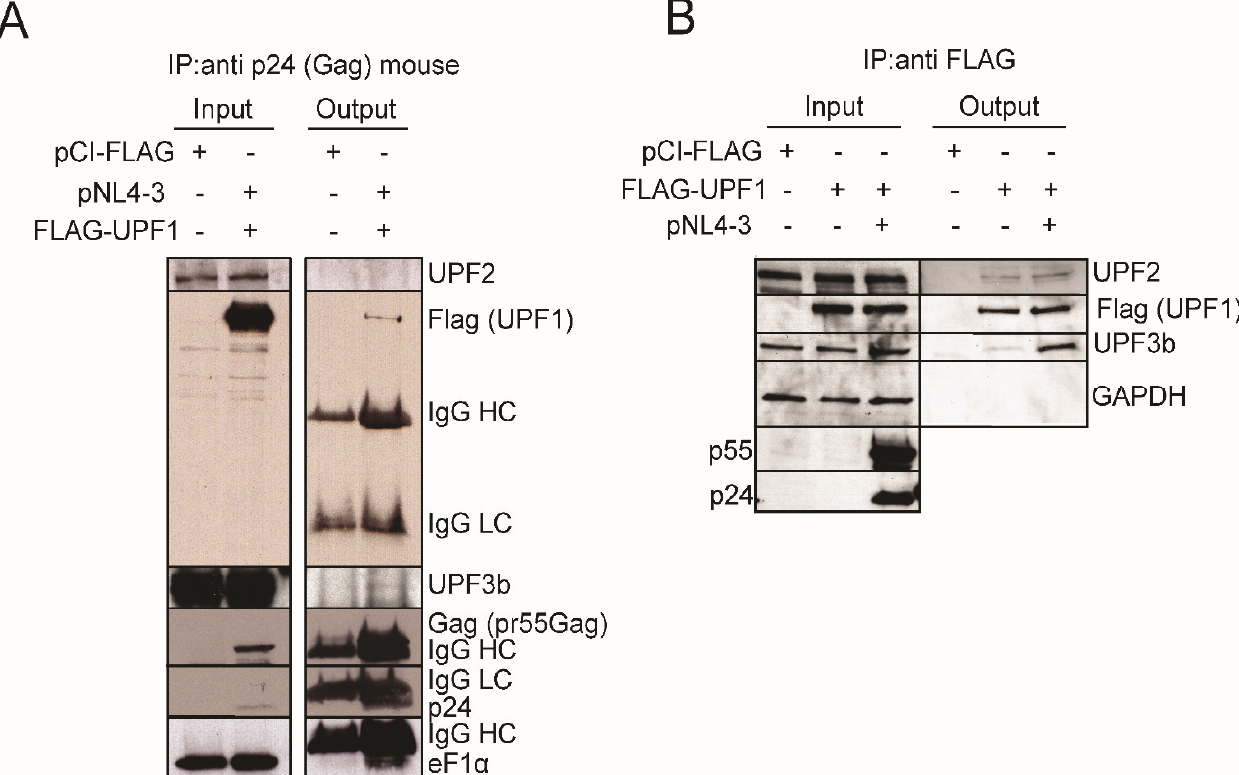
Figure 6. UPF2 is absent from the HIV-1 Gag RNP and UPF3b co-immunoprecipitates with UPF1 under HIV-1 conditions. ( A ) HeLa cells were mock transfected with pCI-FLAG or co- transfected with proviral pNL4-3 DNA and FLAG-UPF1 WT . At 30 h post-transfection, cells were harvested and Gag was immunoprecipitated using a monoclonal anti-p24 antiserum as described in Materials and Methods. Western blot analysis for FLAG-UPF1, UPF3b, Gag (pr55 Gag ), UPF2, and eF1(cid:7) (positive control) was performed. HC: IgG Heavy Chain. LC: IgG Light Chain. Results are representative of two experiments. ( B ) HeLa cells were mock transfected with pCI-FLAG or FLAG-UPF1 or co-transfected with HIV-1 pNL4-3 DNA. Cells were harvested and FLAG-UPF1 was immunoprecipitated. Input lysates and bound complexes were analyzed by western blotting for UPF2, FLAG-UPF1, UPF3b, GAPDH (loading and output control) and Gag (pr55 Gag ). Results shown are representative of three independent experiments. HC: IgG Heavy Chain, LC: IgG Light